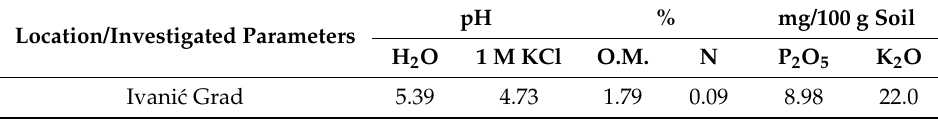
Table 1. Soil nutrient content and soil reaction of the experimental